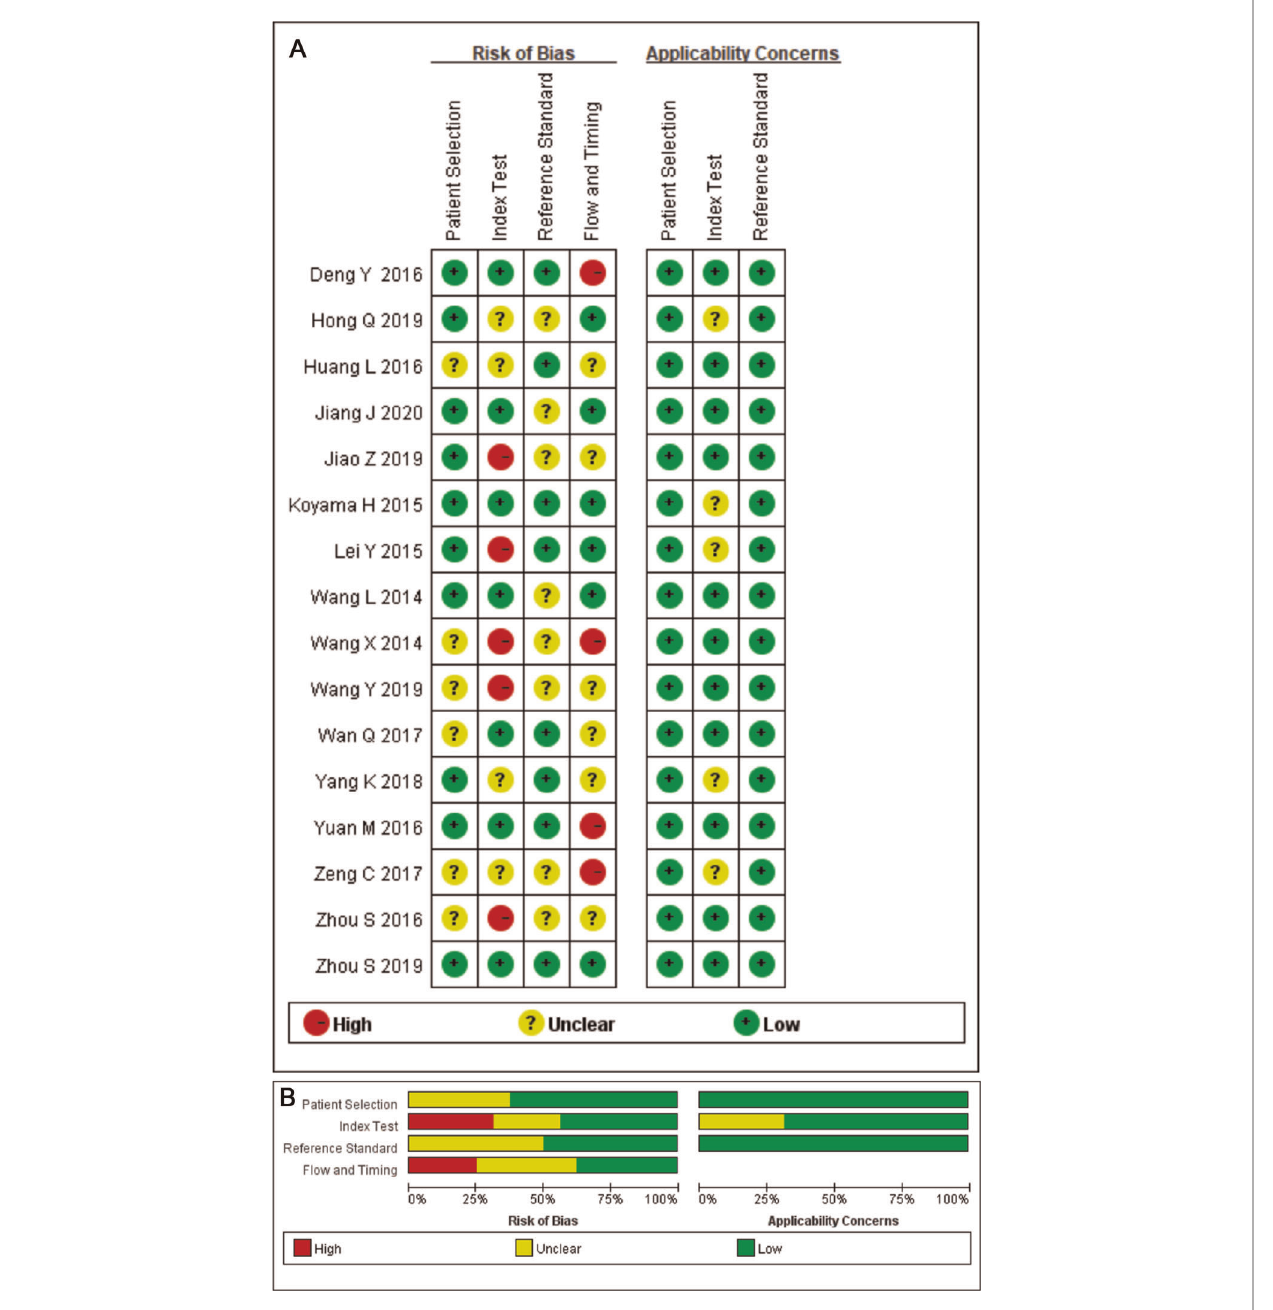
FIGURE 2 | ( A ) Methodological quality summary. ( B ) Methodological quality